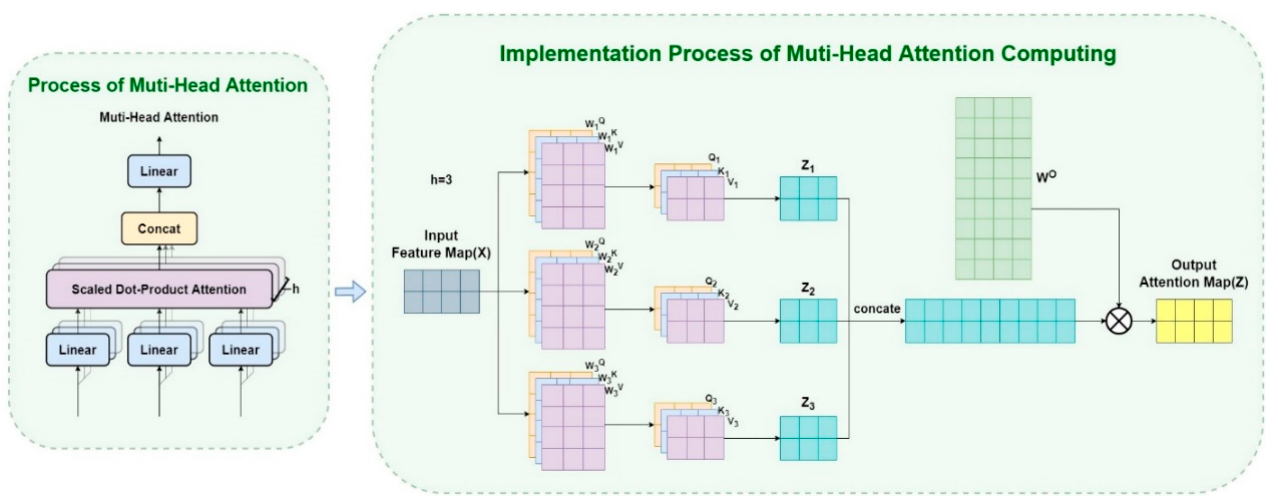
Figure 3. The implementation process of multi-head attention computing.